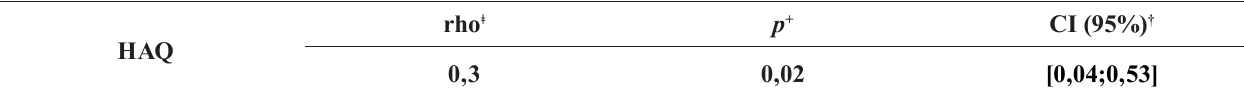
HAQ + p value<0,05; † Confidence Interval; ǂ rho’s Spearman